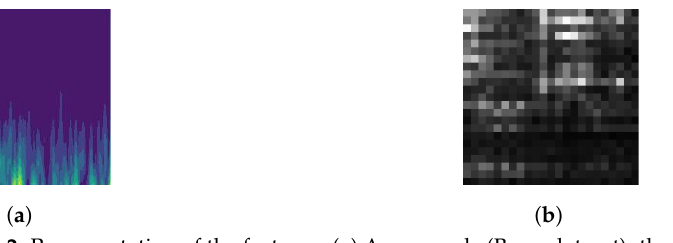
Figure 2. Representation of the features. ( a ) An example (Bonn dataset): the result of a 2D representa- tion. ( b ) An example (CHB-MIT dataset): the result of a 2D representation. For the slices generated by multichannel EEG, the FFT is performed on the data of each channel. With the frequency as the horizontal coordinate and the channel as the vertical coordinate, the result of the FFT is the value in the coordinate. Take a 23-channel slice as an example, with a 1 Hz sampling interval and a frequency band of 1–23 Hz. With frequency as the horizontal coordinate and 23 channels as the vertical coordinate, a 23 × 23-pixel picture is obtained, which is the 2D representation of the slice, as shown in Figure 2b. If the frequency band is extended to 1–46 Hz, then the representation of the features is a 23 × 46-pixel